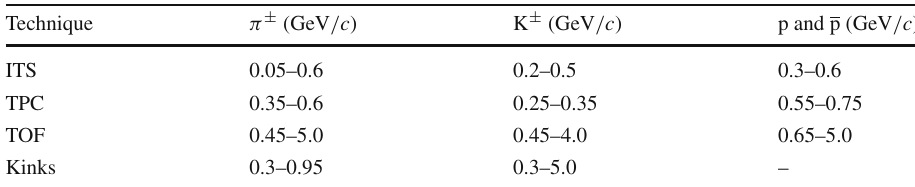
Table 1 Transverse momentum intervals and the corresponding PID methods for pions, kaons and (anti-)protons